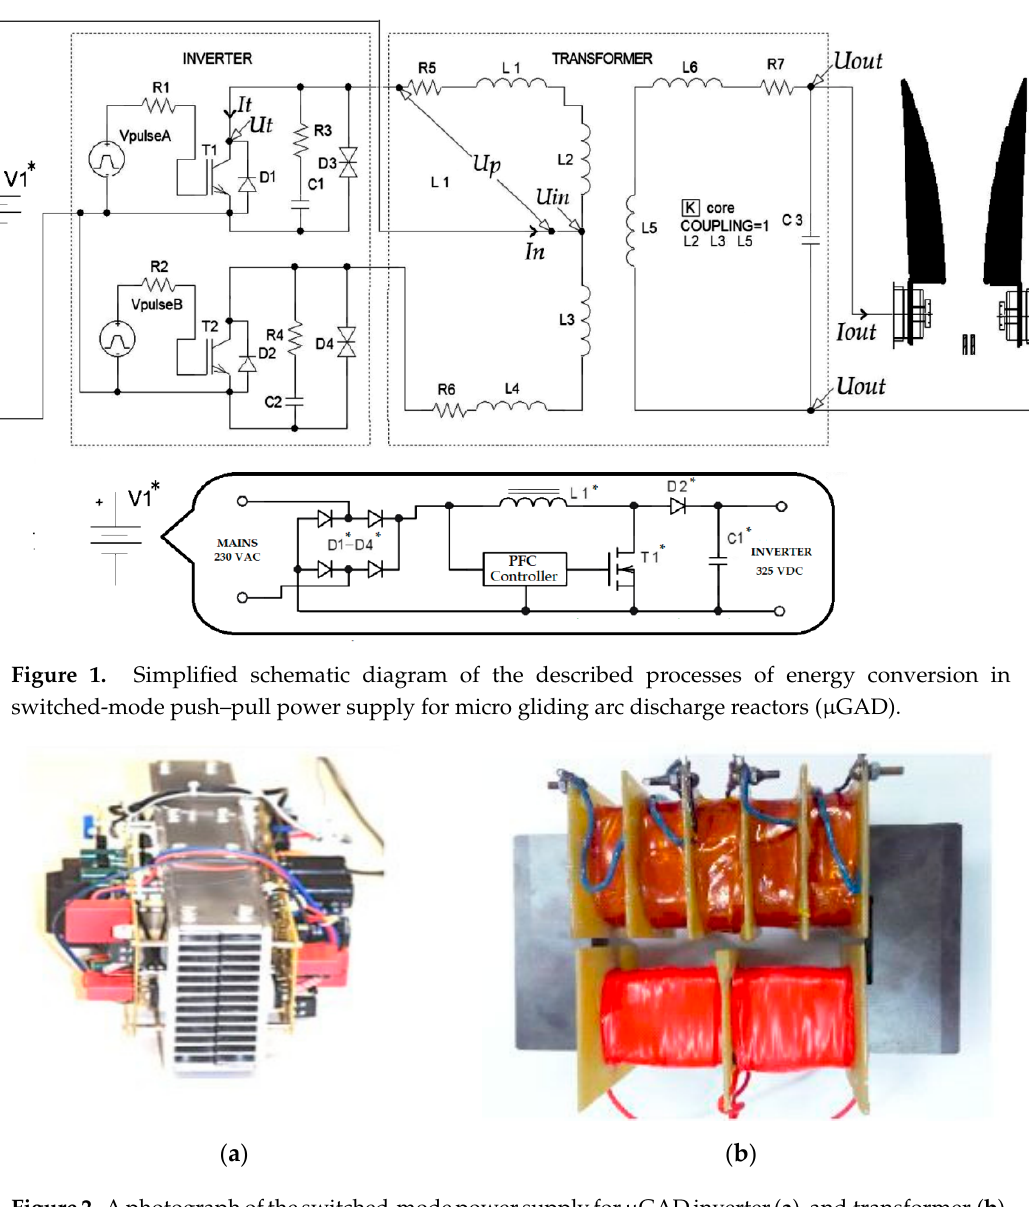
Figure 2. A photograph of the switched-mode power supply for μ GAD inverter ( a ), and transformer Figure2. Aphotographoftheswitched-modepowersupplyfor µ GADinverter( a ), and transformer ( b ( b ).